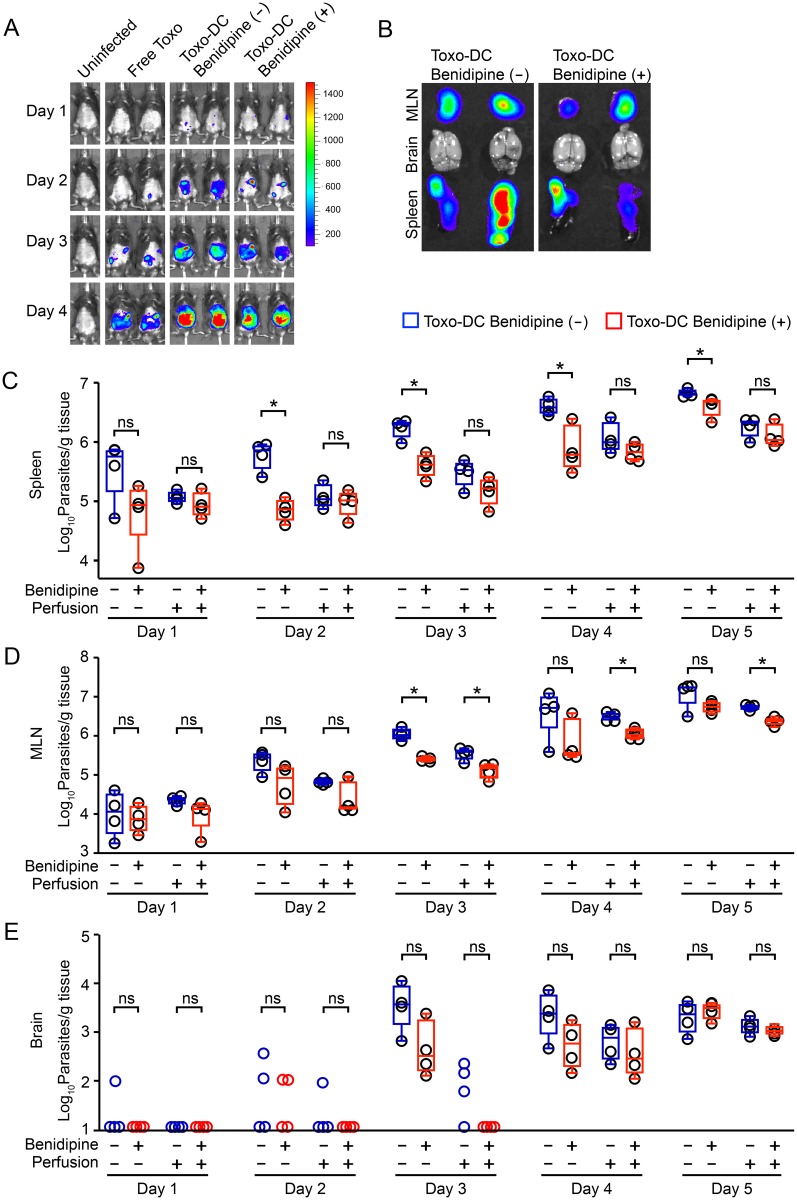
Parasite loads in non-perfused and perfused mice upon VDCC inhibition in adoptively transferred Toxoplasma-infected DCs.(A) C57BL/6 mice were challenged with 5x104 cfu of freshly egressed PTGluc tachyzoites (Free Toxo), 5x104 cfu of tachyzoite-challenged DCs (Toxo-DC Benidipine (-)) or 5x104 cfu tachyzoite-challenged DCs treated with benidipine (Toxo-DC Benidipine (+)). Photonic emissions were assessed by BLI on days 1–4 post-inoculation intraperitoneally. Color scales indicate photon emission (photons/s/cm2/sr) during 180 s exposures. Data are representative of 2 mice from each group (n = 4/group). (B) Ex vivo photonic emissions from spleen, MLN and brains of mice as in (A) on day 5 post-inoculation. Representative data from 2 mice from each group are shown. Scale as in (A). (C, D and E) Parasite loads in spleen, MLN and brain, respectively, on days 1–5 post inoculation quantified by plaquing assays as indicated under Materials and Methods. C57BL/6 mice were inoculated intraperitoneally with 105 cfu of tachyzoite (PTGluc)-challenged DCs ± benidipine pre-treatment, as indicated. Organ extraction was performed without blood perfusion or posterior to perfusion, as indicated. Open circles indicate individual mice. Box-plot and whiskers graphs represent the lower, upper quartiles and median (*: p < 0.05, ns: p ≥ 0.05, Student´s t-test, n = 4).